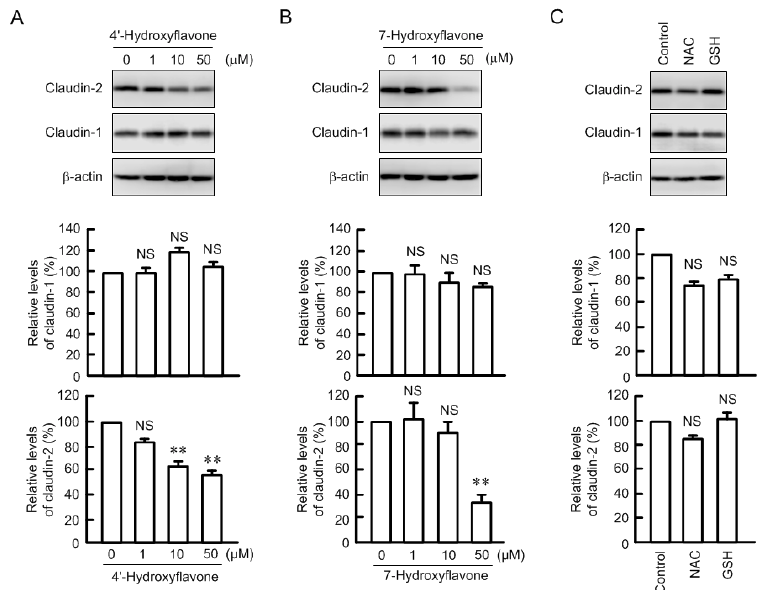
Figure 4. Effects of non-antioxidative flavones and antioxidants on claudin-2 expression. ( A , B ) The cells were incubated in the absence and presence of 4 ′ -hydroxyflavone or 7-hydroxyflavone for 24 h at the concentration indicated. Cell lysates were immunoblotted with anti-claudin-1, claudin-2, or β -actin antibody. The expression levels of claudin-1 and -2 were represented relative to the values in 0 Μ m; ( C ) Cells were incubated in the absence (control) and presence of NAC (1 mM) or GSH (0.1 mM) for 24 h. Cell lysates were immunoblotted with anti-claudin-1, claudin-2, or β -actin antibody. The expression levels of claudin-1 and -2 were represented relative to the values in control. n = 3. ** p < 0.01 significantly different from 0 μ M or control. NS, not significantly different.